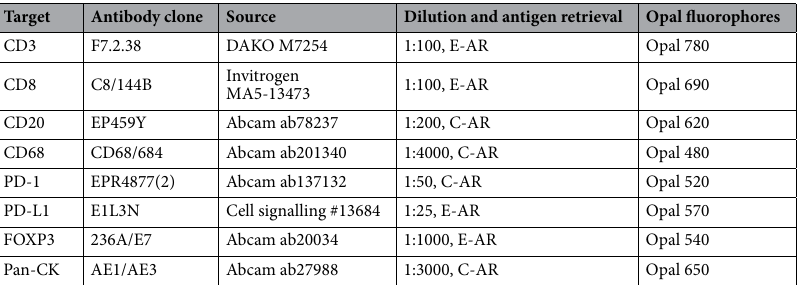
Table 5. Multiplexed immunofluorescence antibodies and their targets. C-AR, citrate antigen retrieval at pH 6.0; E-AR, Ethylenediaminetetraacetic acid (EDTA) antigen retrieval at pH 9.0; Pan-CK, pan-cytokeratin; PD-1, programmed cell death protein-1; PD-L1, programmed death-ligand